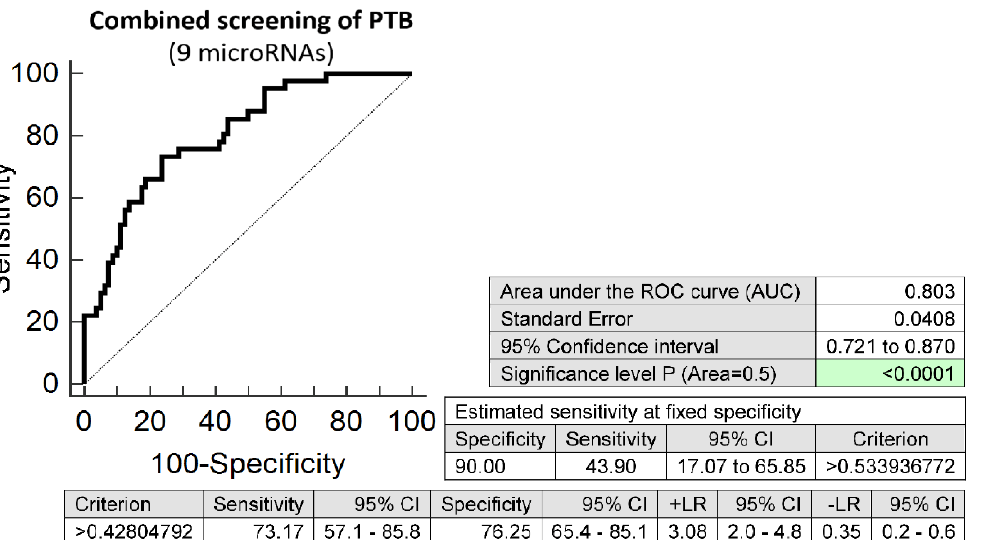
Figure 6. ROC analysis—the best combination of microRNA biomarkers in early prediction of preterm prelabor rupture of membranes. The combination of miR-24-3p, miR-92a-3p, miR-155-5p, and miR-210-3p showed that at 10.0% FPR 30.77% PPROM pregnancies had aberrant microRNA expression profile in the whole peripheral venous blood in early stages of gestation.